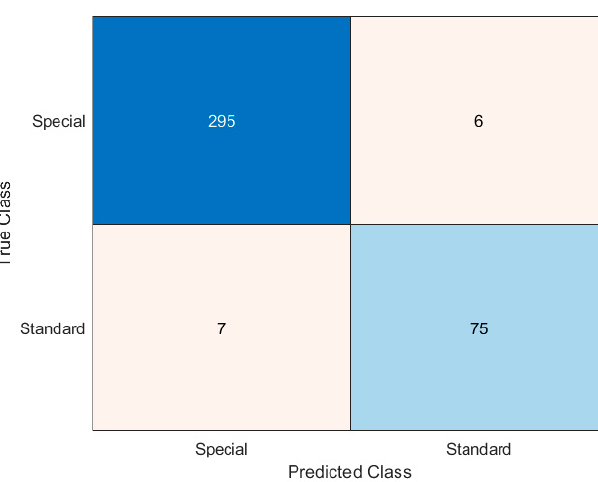
Figure 8. Confusion matrix summarizing first tier event recognition algorithm results.